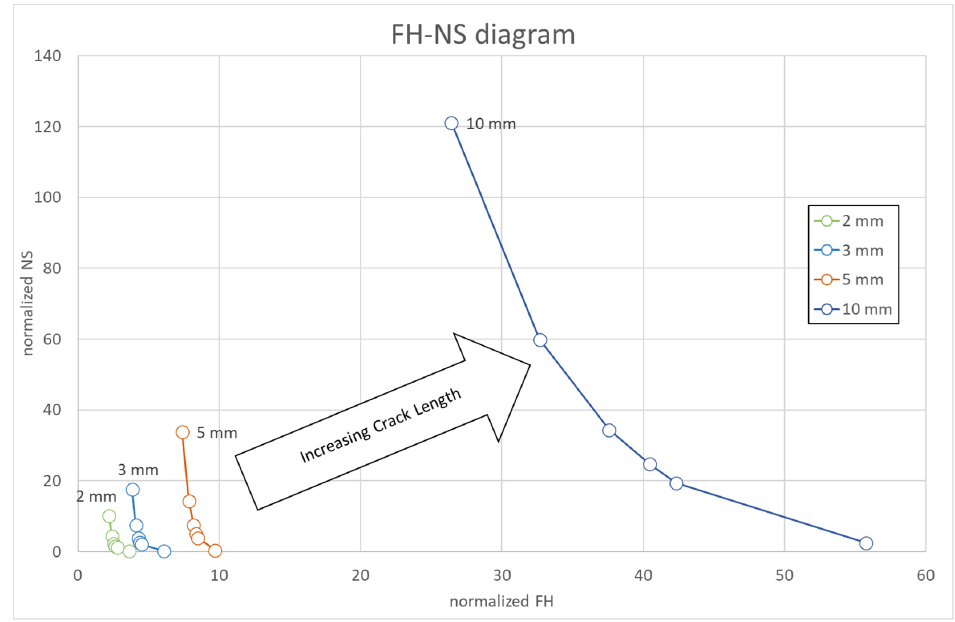
Figure 28. FH–NS diagram at the different crack